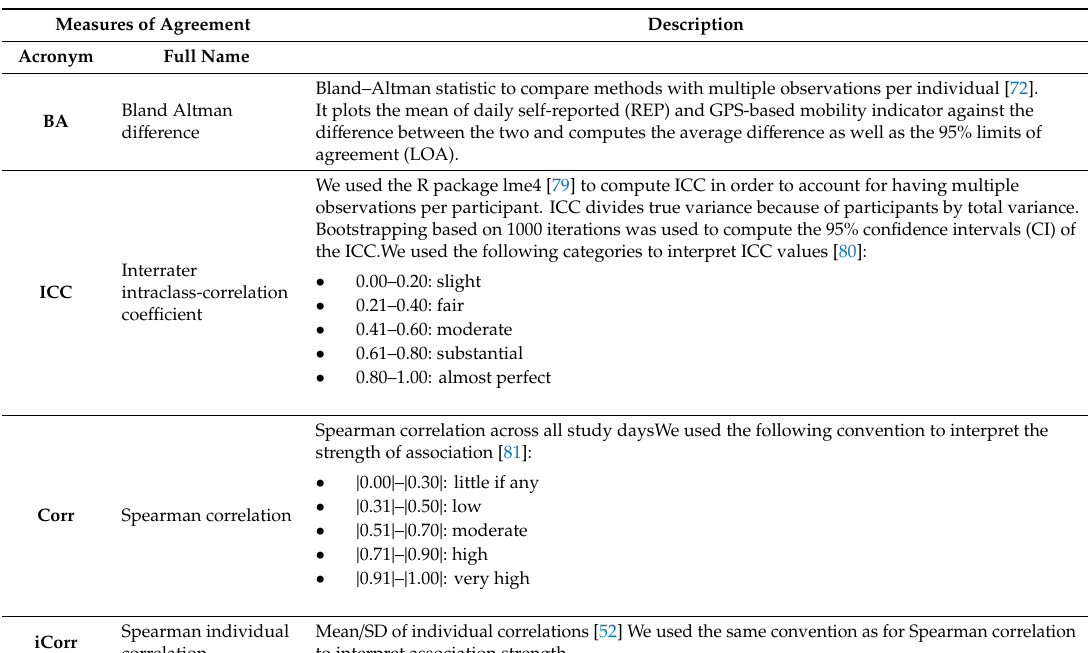
Table A1. Description of measures of agreement between self-reported and GPS-derived mobility indicators.